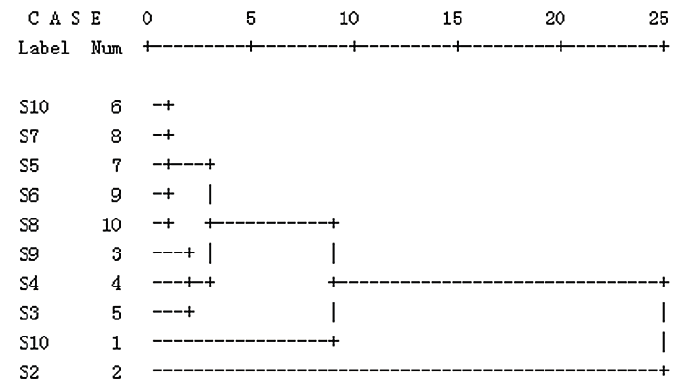
Figure 3. Hierarchical clustering analysis of chicory samples.